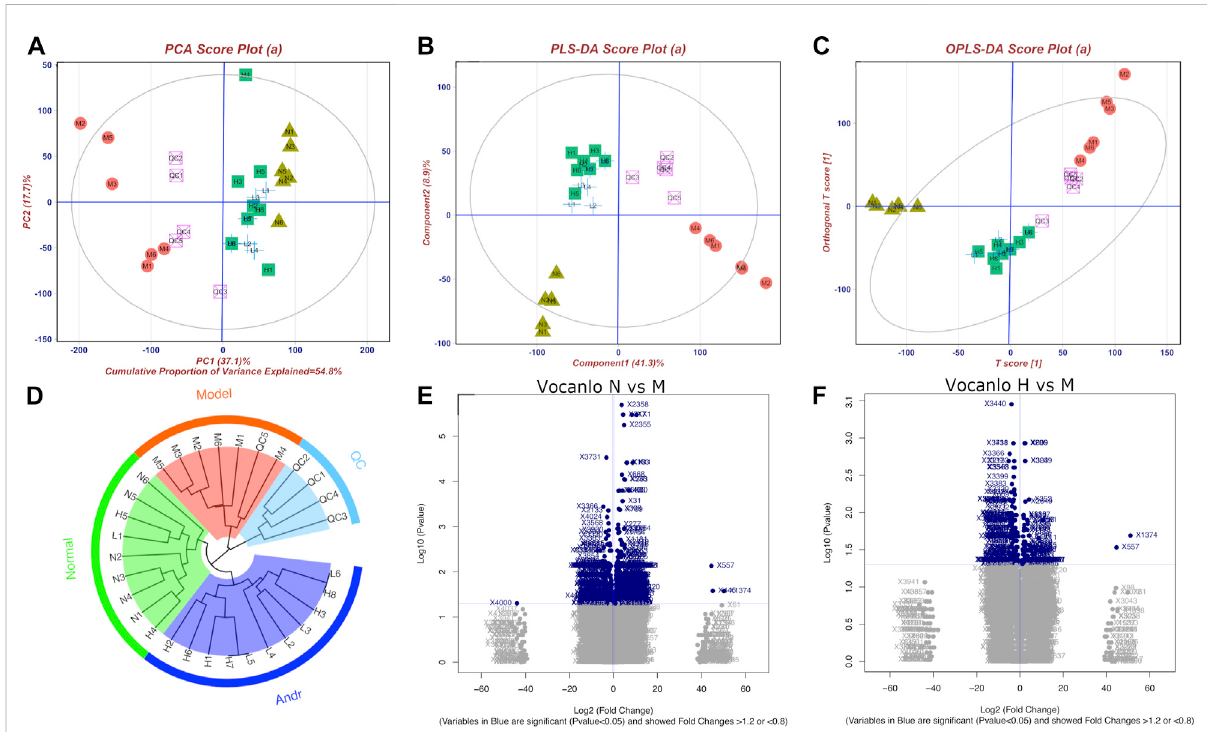
FIGURE 5 Metabonomics pattern recognition, metabolite identi fi cation and pathway enrichment (A) : PCA diagram; (B) PLS-DA diagram; (C) Opls-DA diagram; (D) clusteranalysisdiagram; (E) and (F) areVolcanicdiagramofpeakabundanceofmass-to-chargeratio